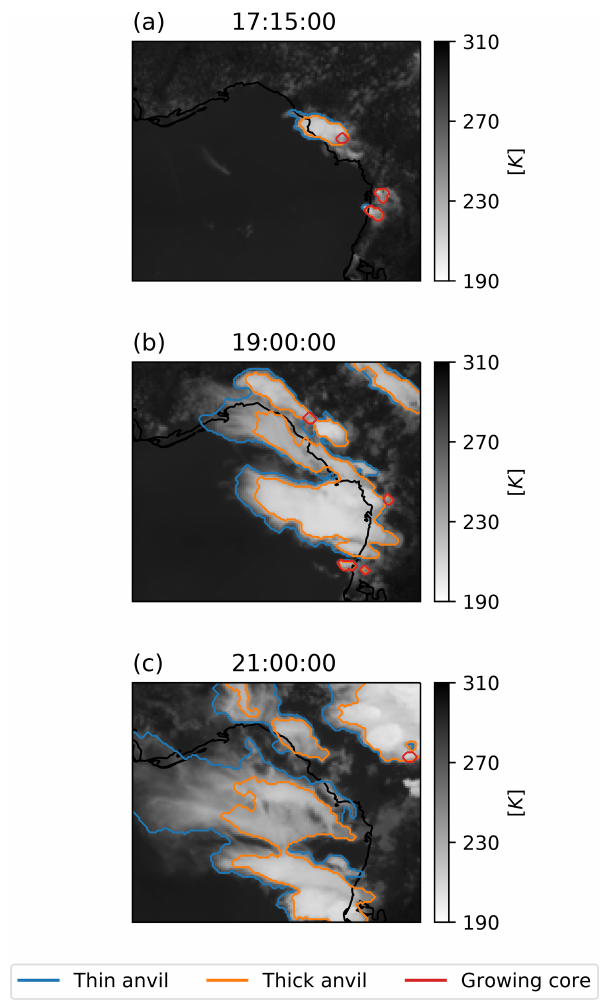
Figure 8. Detected regions of thin anvil cloud (blue), thick anvil cloud (orange), and developing cores (red) overlaid on the GOES- 16 ABI 10.8µm brightness temperature field for the DCC cluster from Fig. 1. The three stages of the DCC life cycle are shown; the growth phase (a) , the mature phase (b) , and the dissipating phase (c) . Note that the anvil region continues to be detected in panel (c) after growing cores are no longer